Question: Name the type of graph shown.
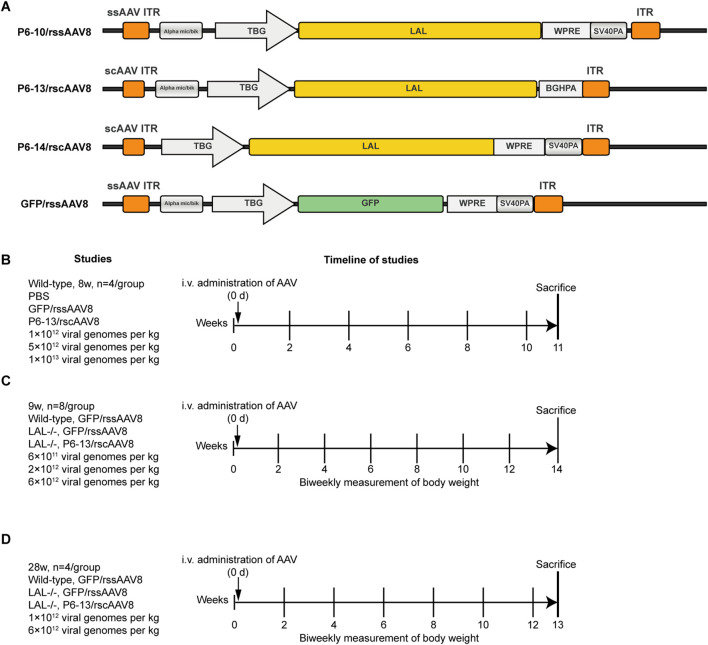
Answer: line